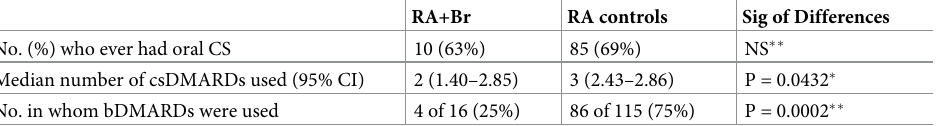
CS = corticosteroid therapy; csDMARDs = conventional synthetic disease modifying anti-rheumatic